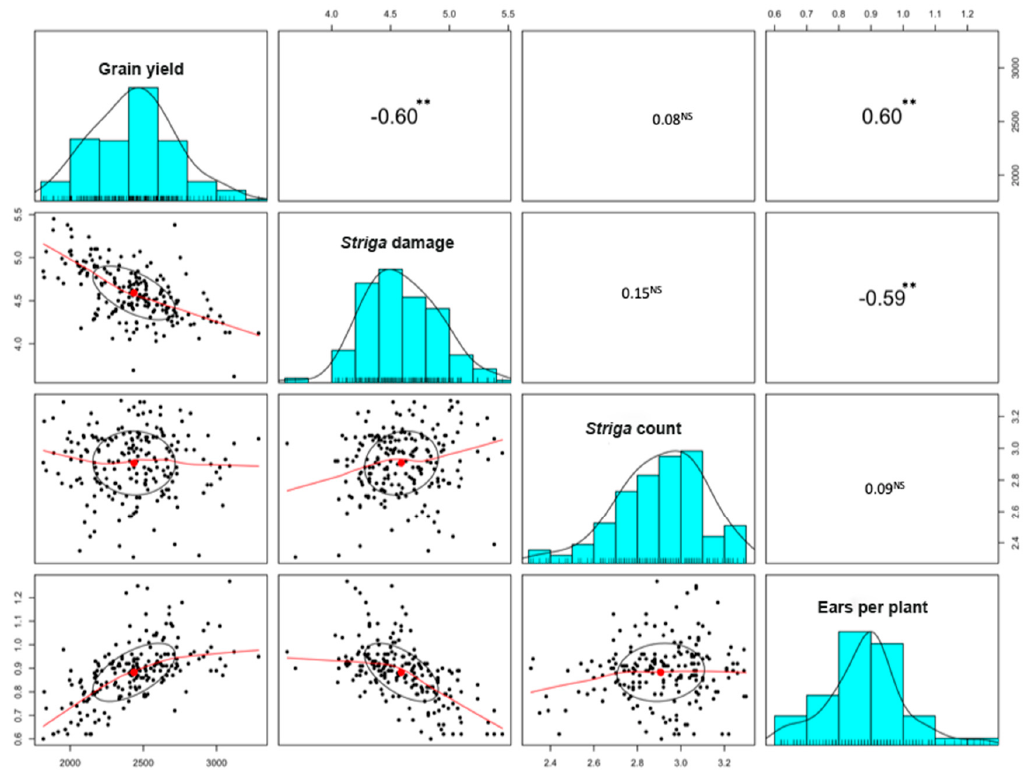
Figure 2. Correlation between grain yield and other Striga resistance indicator traits in an F 2:3 mapping population derived from TZEEI 79 × TZdEEI 11 under artificial Striga infestation. The axis displayed the range of values obtained for each trait; black circles represent the most predominant values for each trait among the genotypes while the red lines represent the direction of the relationship between two traits. ** = 0.01 and indicates highly significant.